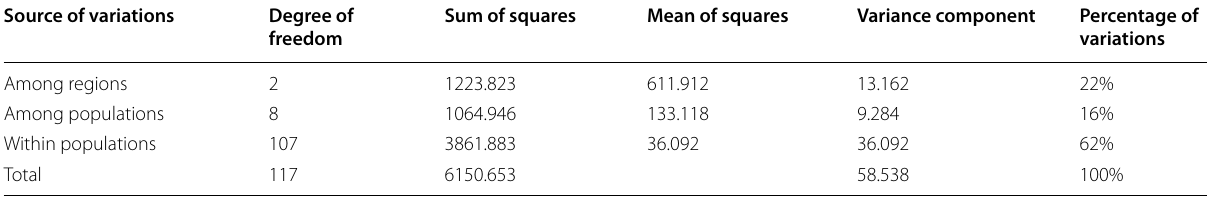
a Combined DAMD and ISSR data matrices